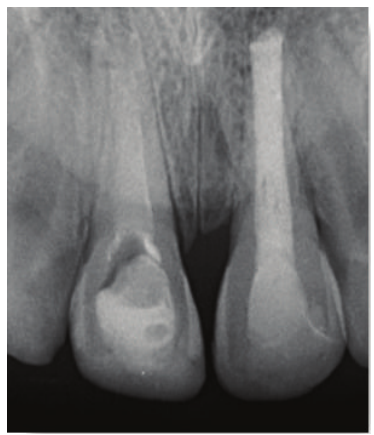
Figure 5: 18-months follow-up of replanted tooth.